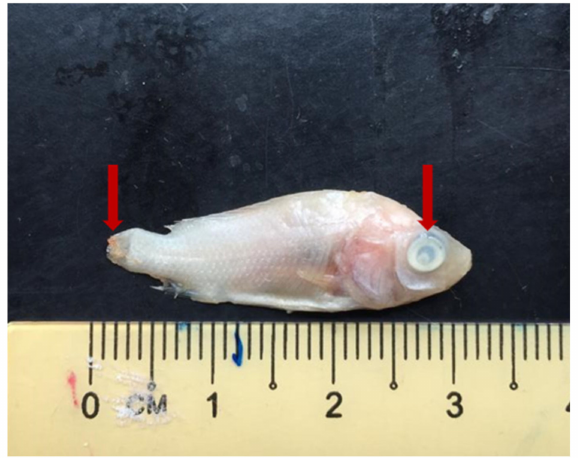
Figure 3. The external clinical signs observed on tilapia larvae after being challenged with Streptococ- cus agalactiae in the control group (T2) include cornea opacity and caudal fin erosion, as indicated by the red